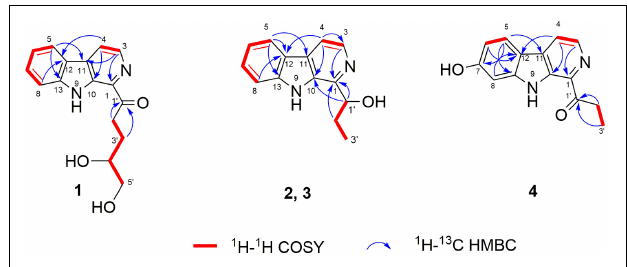
FIGURE 2 | Key COSY and HMBC correlations of compounds 1 – 4 .